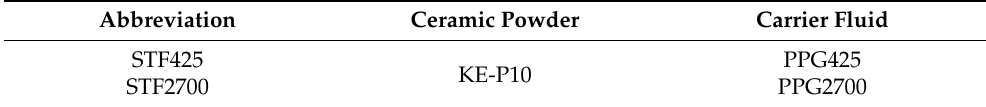
Figure 1. Scheme of the mixer used for the STF preparation. Table 2. Properties of spherical silica powders. Table 2. Properties of spherical silica